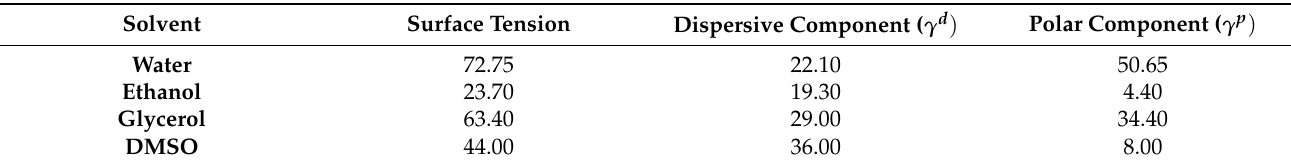
Table 1. Surface tension, and polar and dispersive components of liquids. Adapted with permission from [20]. Copyright 2022. American Chemical